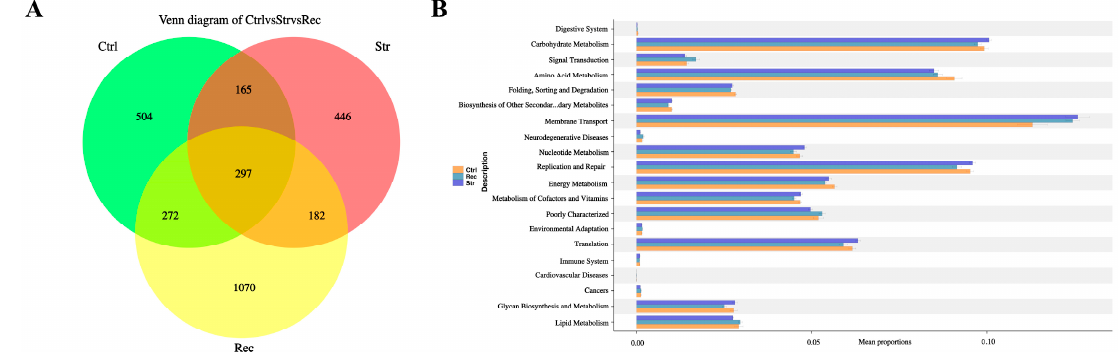
Figure 8. ( A ) Venn diagram analysis depicting the numbers of shared and unique OTUs in control groups, transport groups, and recovery group. ( B ) The abundance ratio of gut microbiota among the control groups, transport groups, and recovery group predicted the level 2 function.